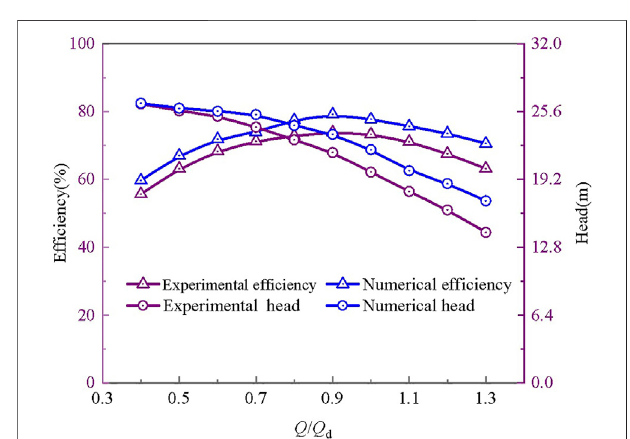
FIGURE 6 | Comparison of simulation results with